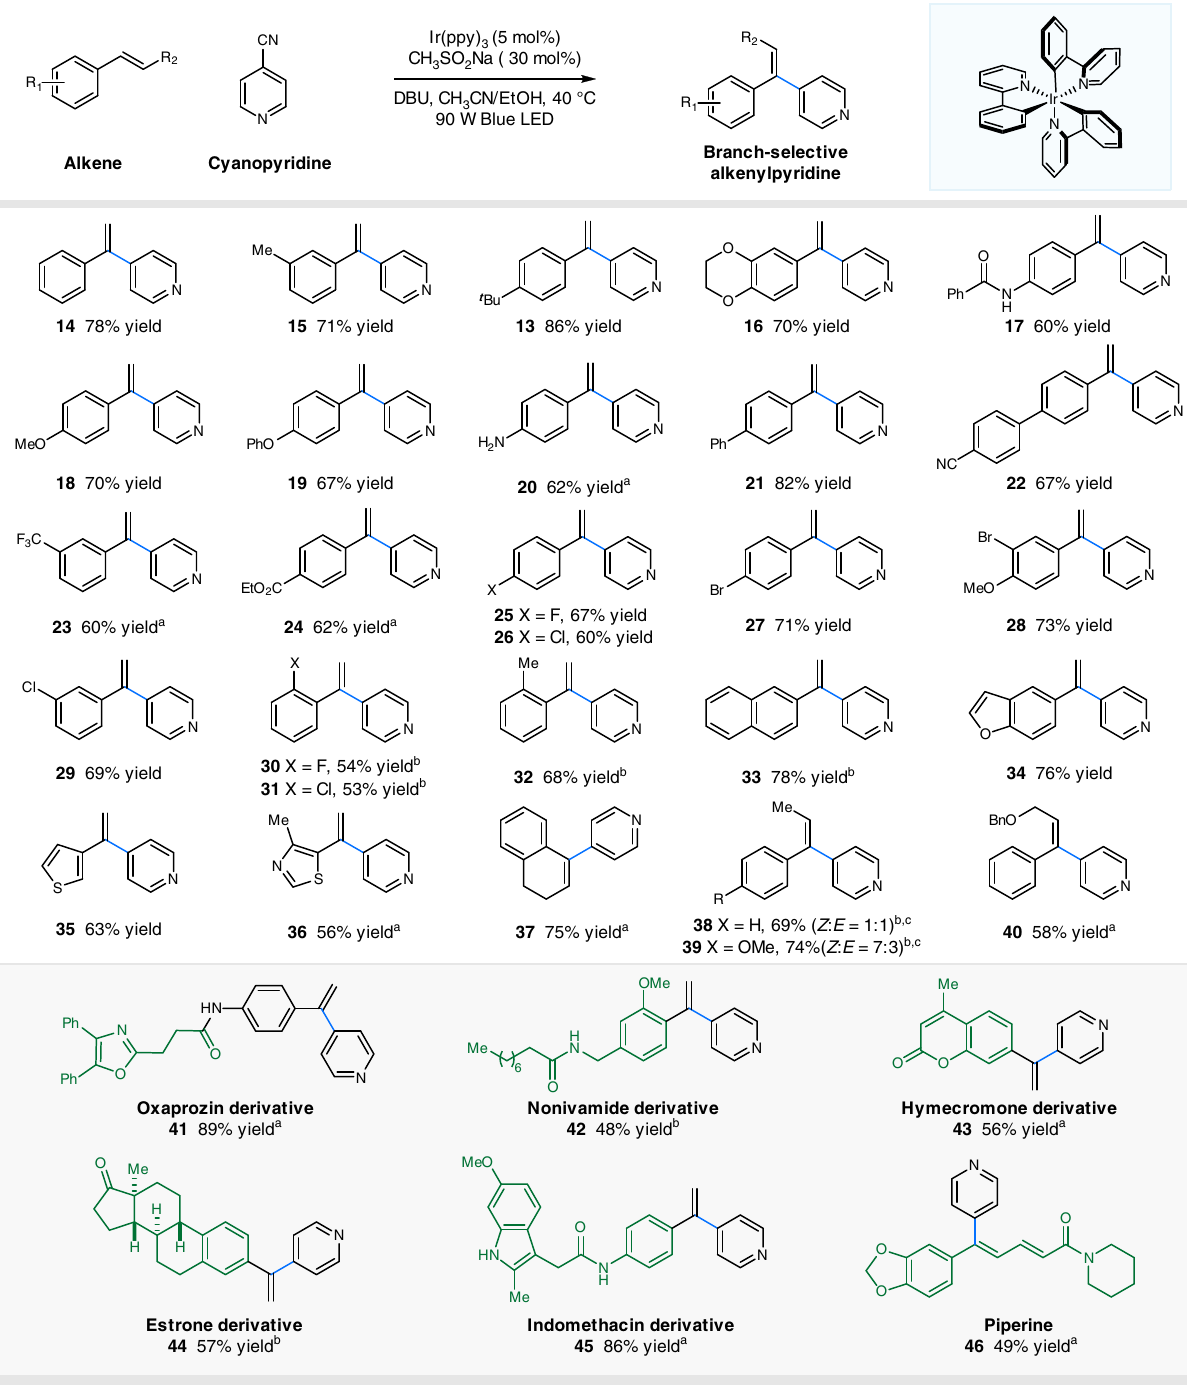
Fig. 3 Substrate scope of ole fi ns. Reaction conditions: Ir(ppy) 3 (5 mol%), MeSO 2 Na (30 mol%), alkene (0. mmol), 4-cyanopyridine (2.0 equiv.), DBU (3 equiv.), MeCN/EtOH (1:1), 90 W blue light-emitting diode (LED), 40 °C, 24 h. All cited yields are isolated yields. a Employed with 4-Cl-C 6 H 4 SO 2 Na (1.0 equiv). b Employed with 4-Cl-C 6 H 4 SO 2 Na (0.5 equiv.). c The ratio was determined by proton nuclear magnetic resonance ( 1 H NMR)